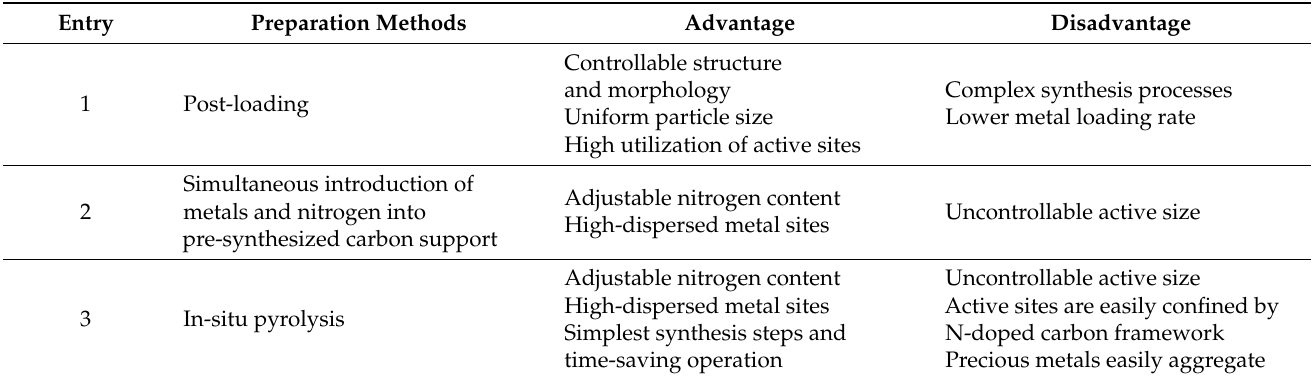
Table 1. The advantage and disadvantage of different synthesized methods of transition metal anchored on N-doped carbon